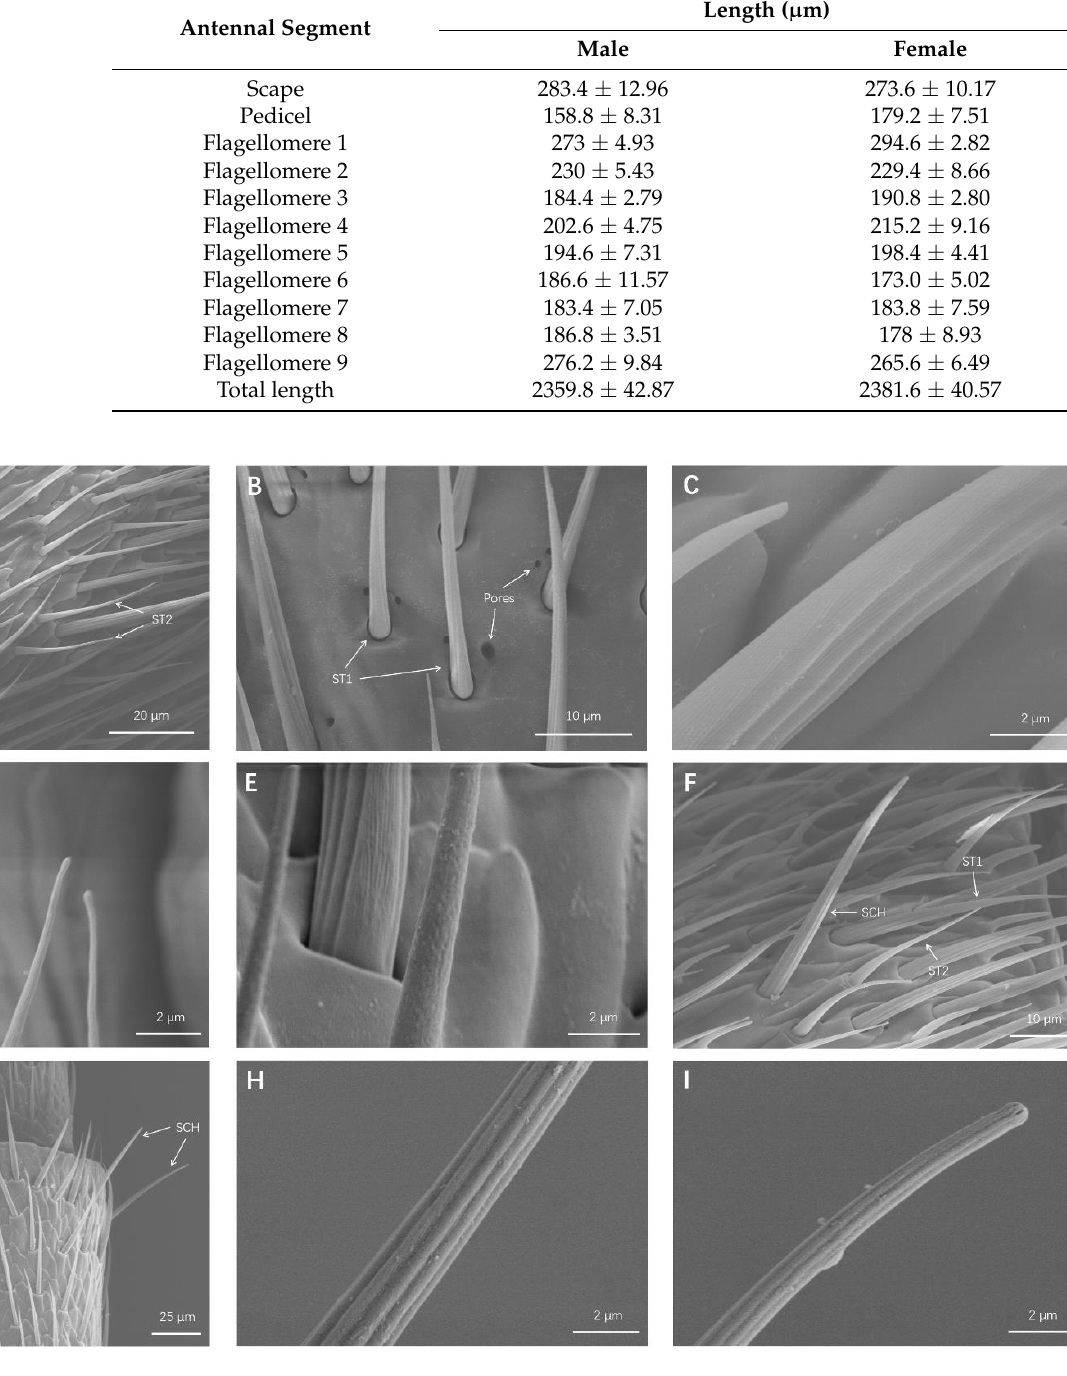
Figure 2. SEM micrographs of sensilla trichodea (ST) and sensilla chaetica (SCH). ( A ) ST1 and ST2 distributed on a flagellomere. ( B ) Pores were scattered around the socket of ST1. ( C ) Magnification of curved wall of ST1. ( D ) Magnification of tip of ST1. ( E ) Magnification of pores on wall of ST2. ( F ) SCH, ST1, and ST2 distributed on a flagellomere. ( G ) SCH sparsely located around the top of a flagellomere. ( H ) Magnification of side wall of SCH. ( I ) Magnification of blunt tip of SCH. Table 3. Lengths , widths, and density of various adult O. communa antennal sensilla. + to ++++ in- Sensilla Trichodea 1 (ST1) dicate relative density of different sensilla. ST1 were long, thin, hair-like sensilla, tapering to a fine point (Figure 2A). Some cutic- ular pores were scattered around the ST1 sockets (Figure 2B). ST1 were situated in